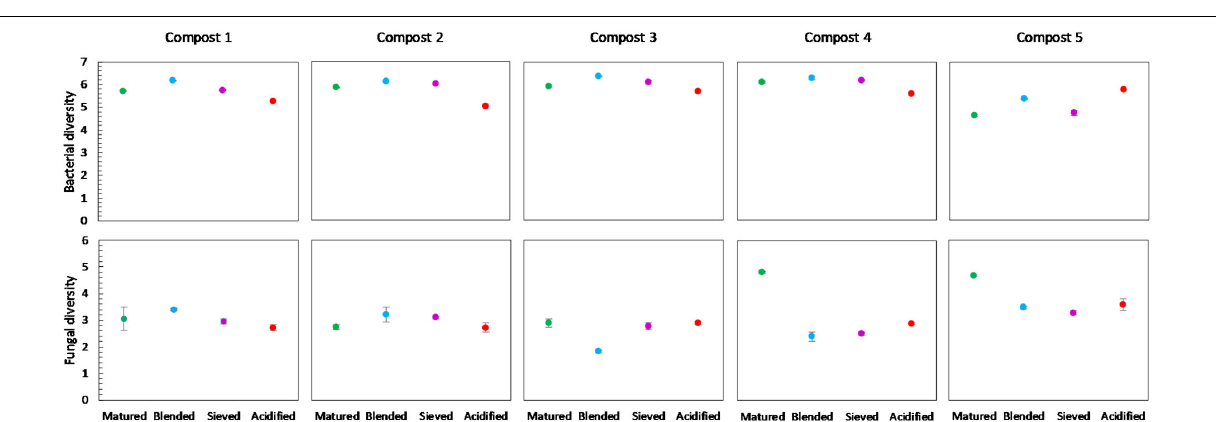
FIGURE 8 | Microbial diversity in matured, blended, sieved and acidified composts in the five compost batches. On top: mean bacterial diversity ± standard error in the five compost batches, calculated as the Shannon diversity index from 16S V3-V4 rRNA gene sequencing data. At the bottom: mean fungal diversity ± standard error in the five compost batches, calculated as the Shannon diversity index from ITS2 gene sequencing